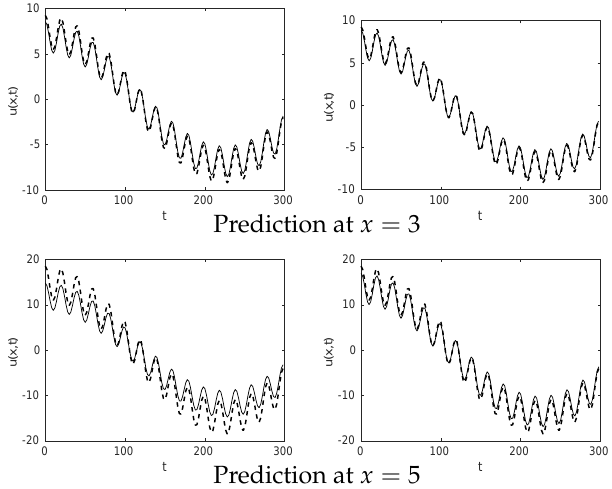
Figure 3. Predictions in the toy model (11). ( Left ) linear approximation. ( Right ) quadratic approximation. Continuous and dashed lines represent the original solution and the prediction,